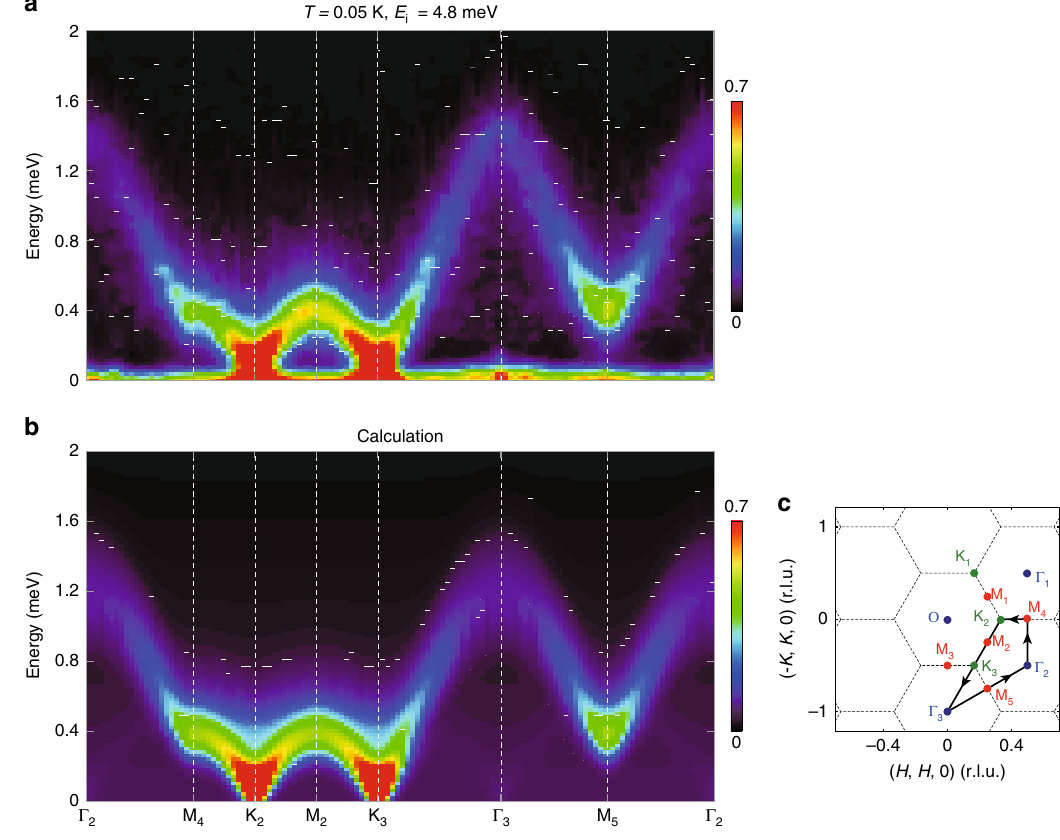
Fig. 3 Measured and calculated spin wave dispersions in TmMgGaO 4 at T = 0.05 K. a Intensity of the spin-excitation spectra along the high-symmetry momentum directions as illustrated by the black solid lines in c . b The simulated spin excitation dispersion using the model speci fi ed in the text. The color bars indicate scattering intensity in arbitrary unit in linear scale. c Sketch of the reciprocal space. Black dashed lines indicate the Brillouin zone